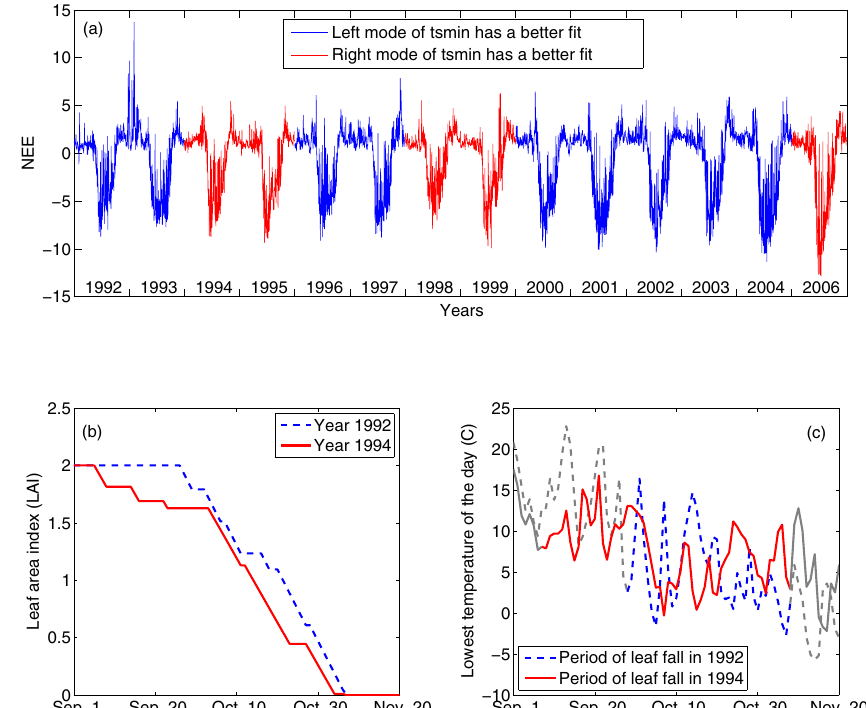
Figure 6. (a) Observed NEE with years highlighted in red where the left mode of tsmin has a better model fit and years highlighted in blue where the right mode of tsmin has a better model fit; (b) the simulated leaf area index (LAI) of years 1992 and 1994; and (c) the recorded lowest temperature of years 1992 (blue) and 1994 (red). The blue and red lines in (c) highlight the corresponding periods of leaf fall until LAI becomes zero for 1992 and 1994, respectively. The color scheme is synchronized between (a) , (b) , and (c) frames. Note that decreases in LAI as predicted by our simplified version of DALEC reflect chlorophyll loss rather than leaf